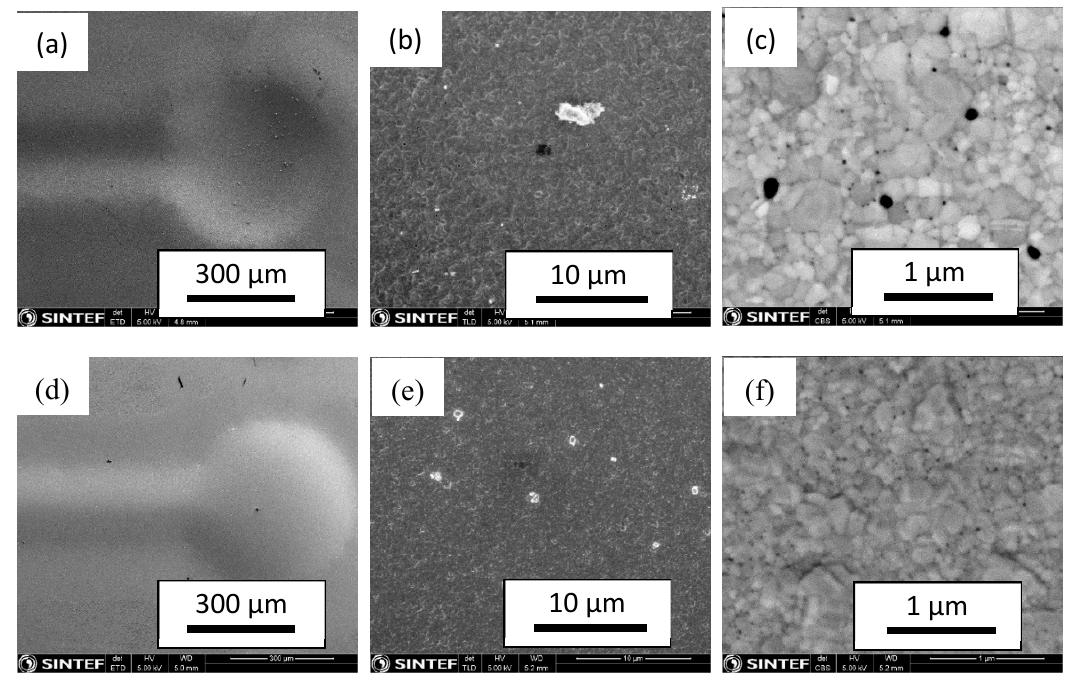
Figure 12. SEM images of the Pd 77 Ag 23 film after testing: ( a – c ) feed (growth side) and ( d – f ) permeate (silicon side), at different magnifications.